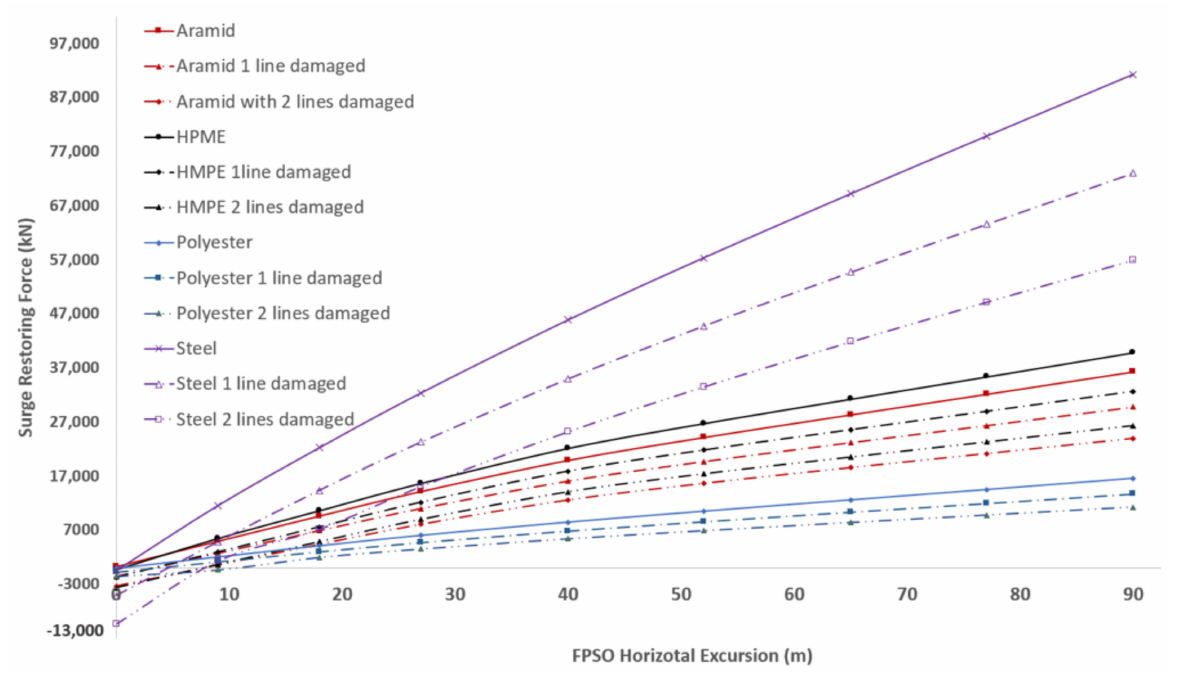
Figure 8. Comparison of mooring system surge restoring forces for different mooring materials in the intact, single-, and double-line failure